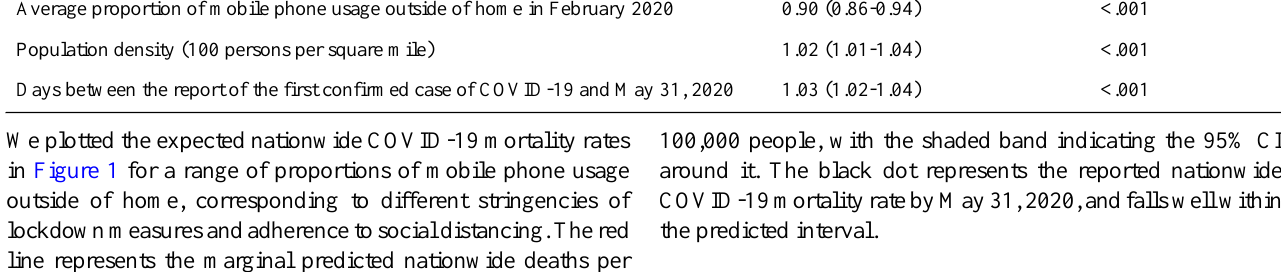
P valueIncidence rate ratio (95% CI)Variables